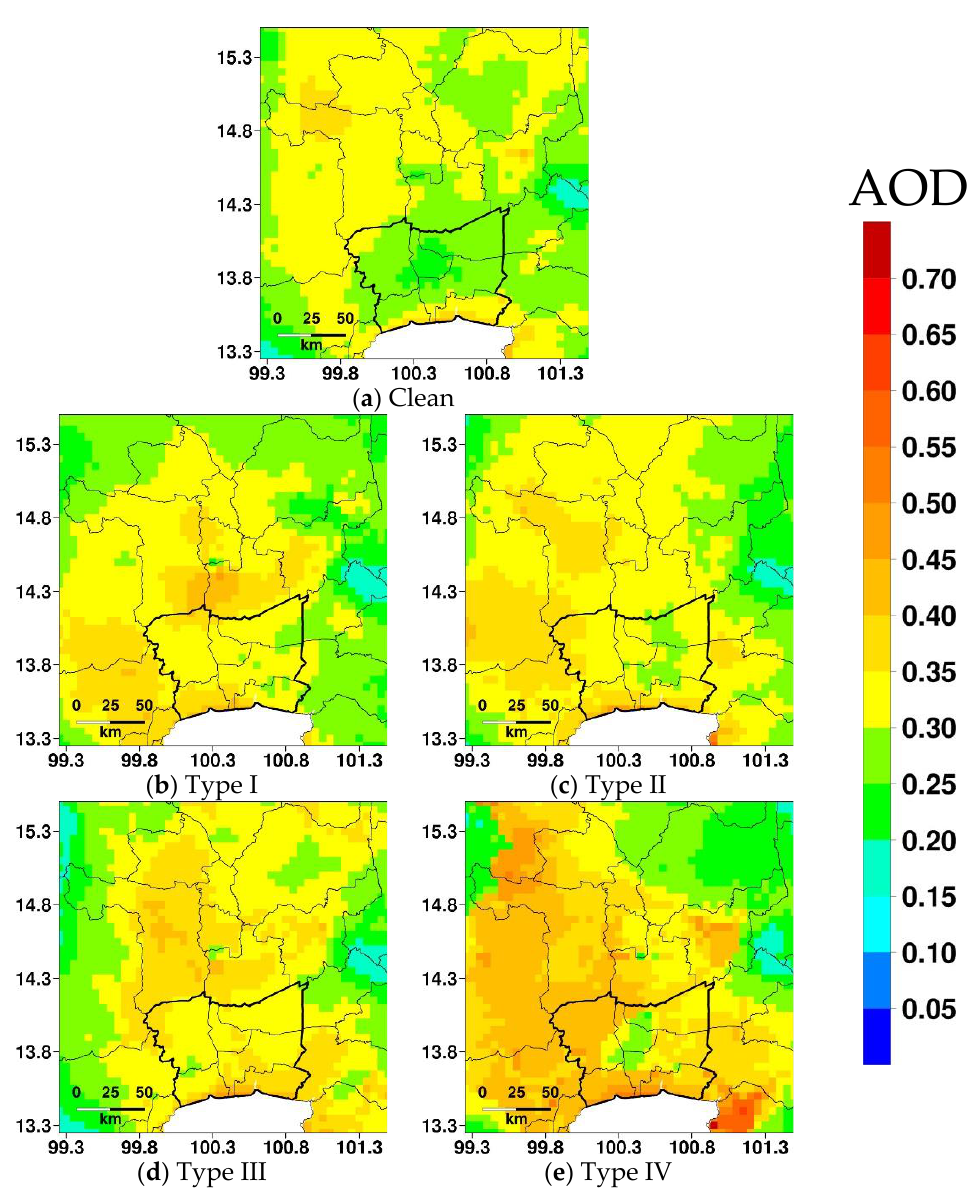
Figure 5. Average AOD at 500 nm from AHI over Greater Bangkok (bordered by the thick lines) and its vicinity by haze